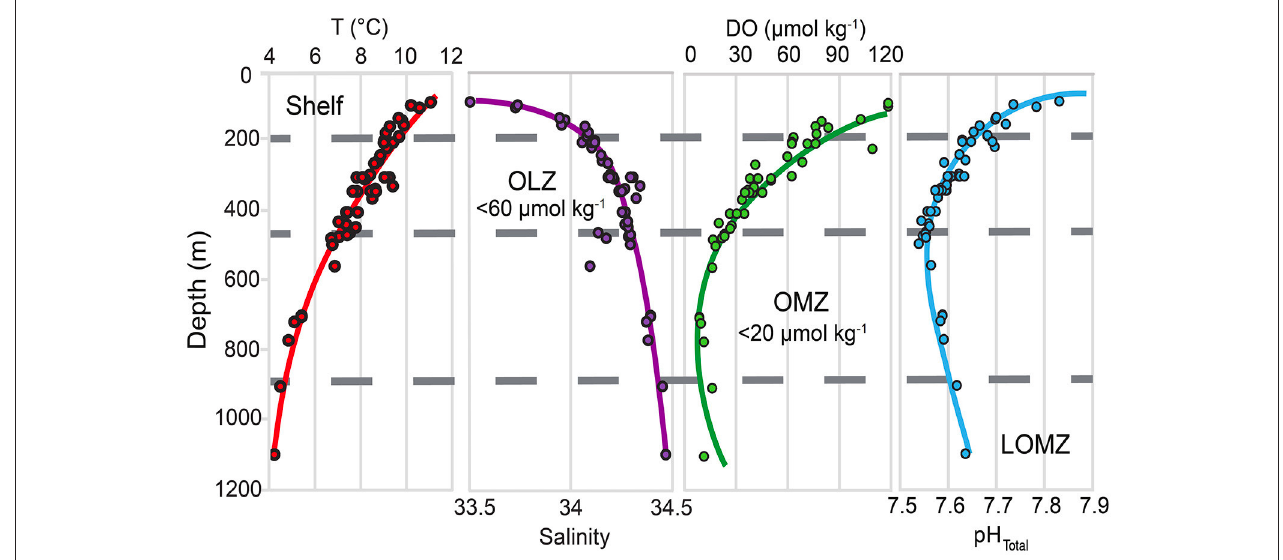
FIGURE 1 | Depth profiles for temperature (T), salinity, dissolved oxygen (DO), and in situ pH Total in southern California, indicating the vertical structure of key variables likely to be modified under climate change. Horizontal gray dashed lines separate the continental margin into four depth zones: Shelf, Oxygen Limited Zone (OLZ), Oxygen Minimum Zone (OMZ), and Lower Oxygen Minimum Zone (LOMZ). Points indicate trawl depths of urchin collection sites throughout southern